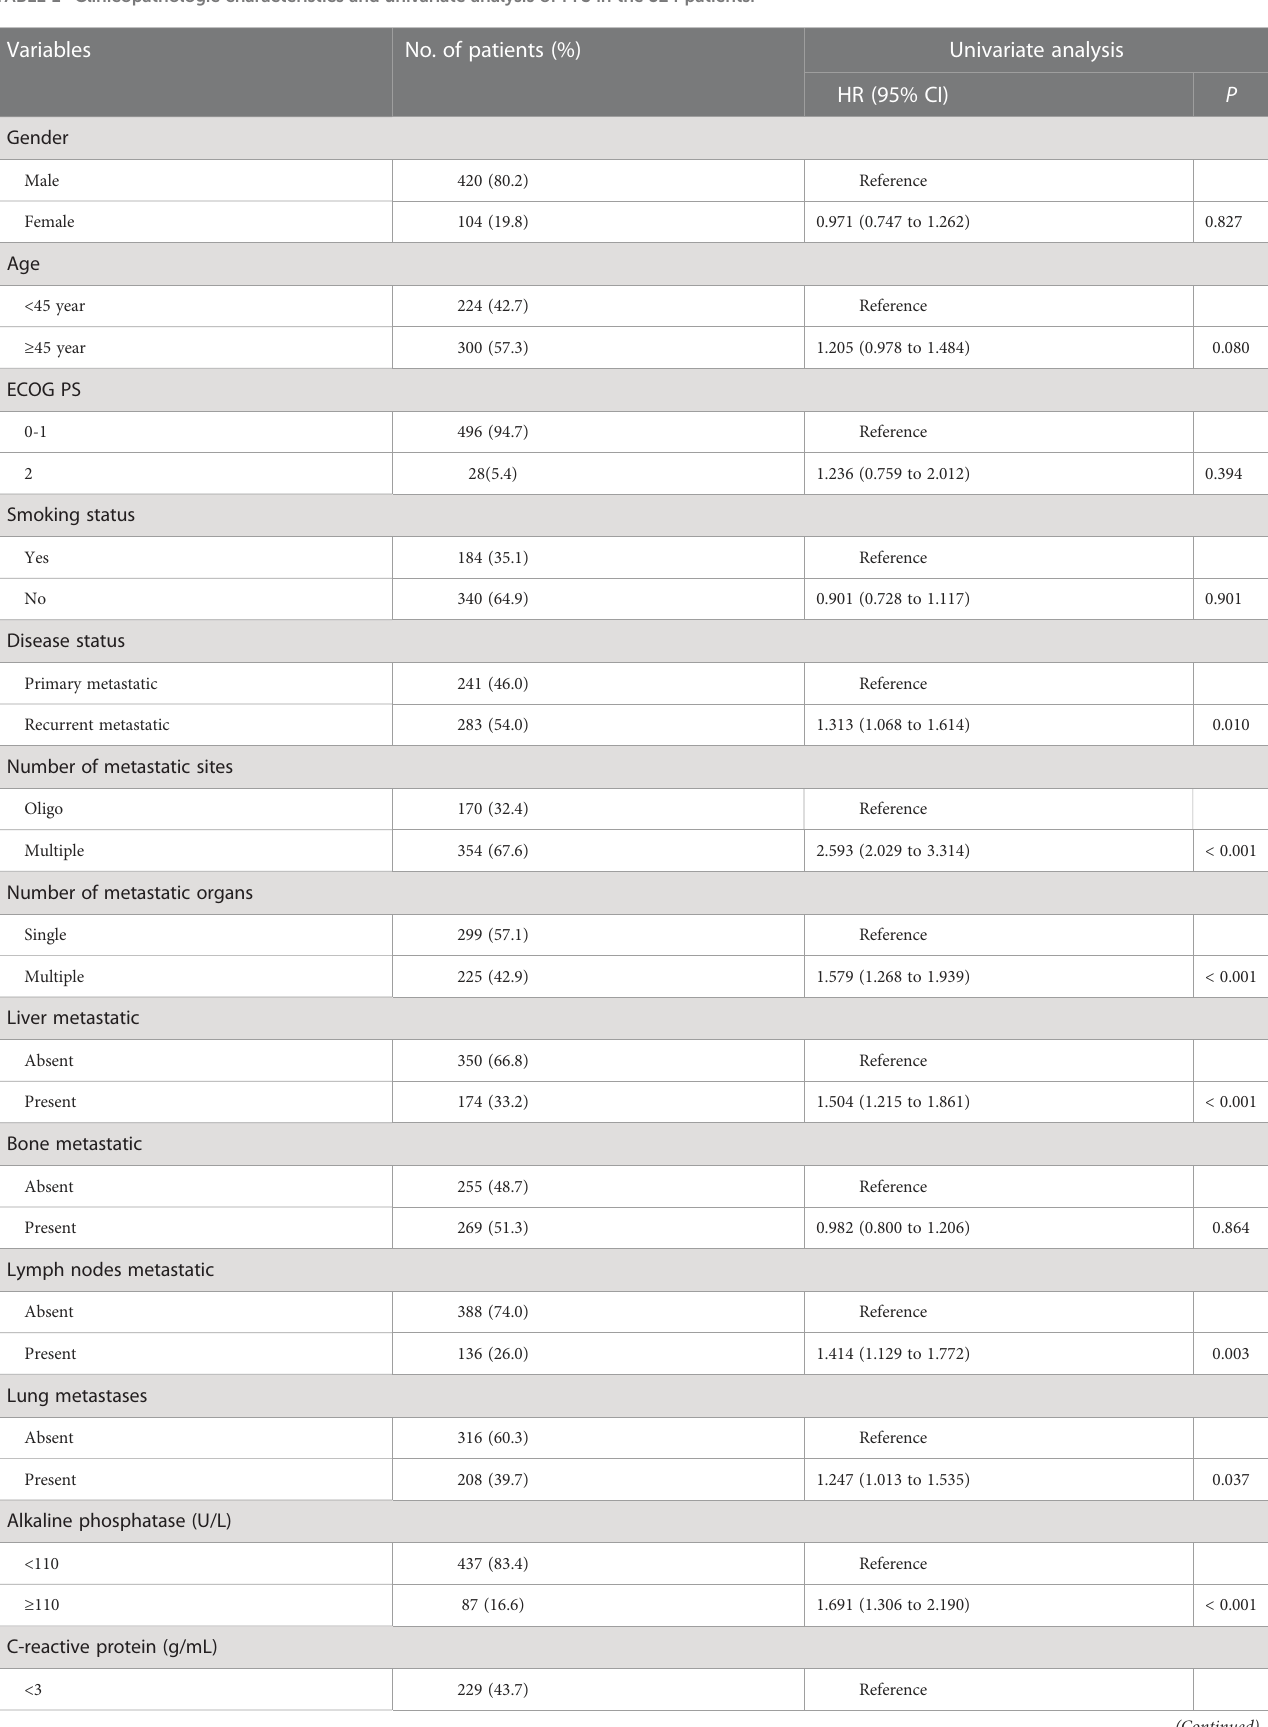
TABLE 1 Clinicopathologic characteristics and univariate analysis of PFS in the 524